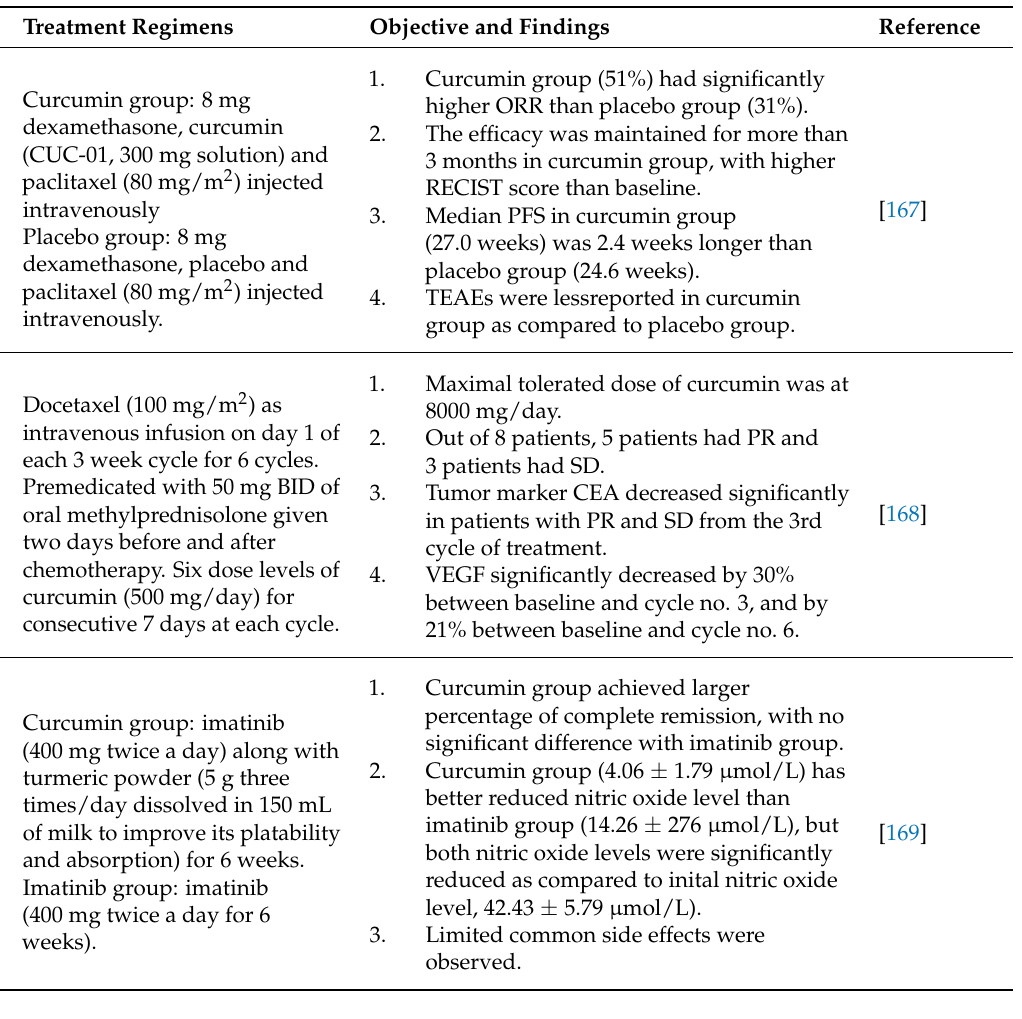
Table 2. Completed clinical trials in curcumin combination